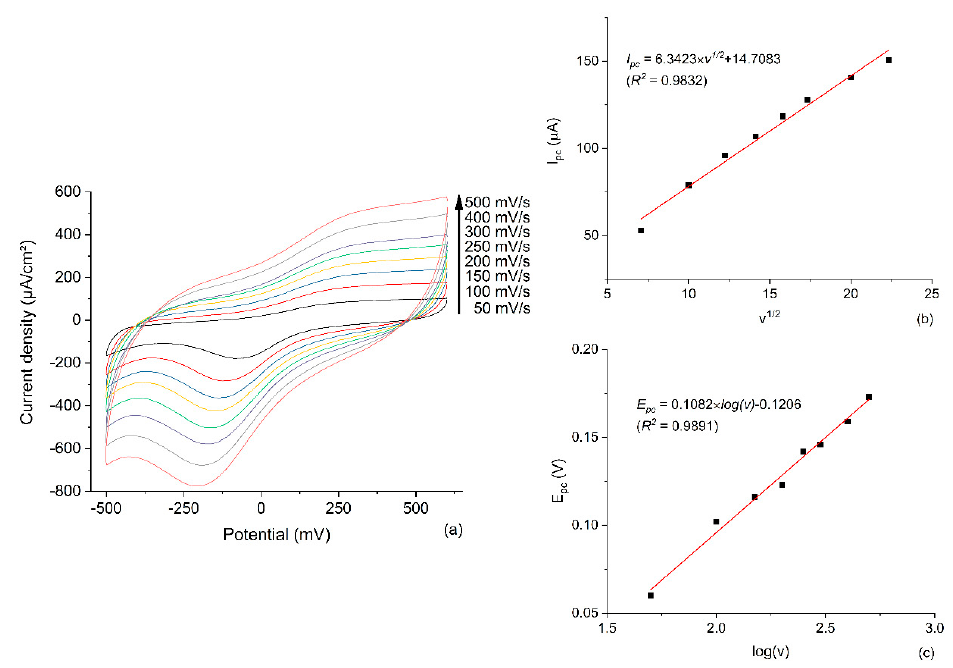
Figure 2. Cyclic voltammetry of the Pd/MWCNT composite in different concentrations of deuterated water ( a ): in the inset ( b ) it is shown the increase in the capacitance of the electric double layer; ( c ) shows the effect of the pH of the solu- tion on the anodic and cathodic current ( d ) .